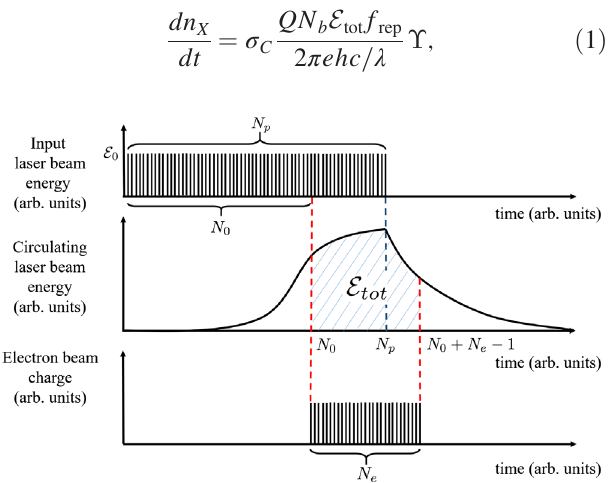
FIG. 1. Temporal patterns of (top) the input laser beam pulse train energy, (middle) the intracavity laser beam energy and (bottom) the electron beam bunch train intensity, for the use of a burst mode FPC in Compton experiments. The total effective laser beam energy used for Compton scattering off the N e electron bunches is denoted E tot